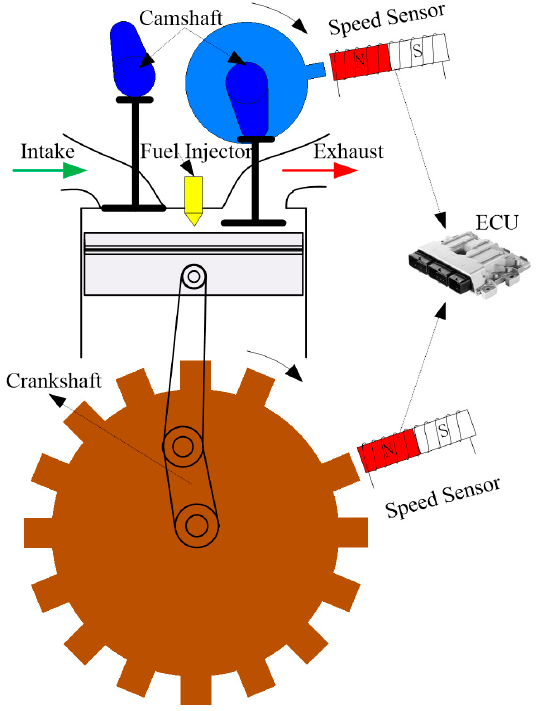
Figure 1. The schematic diagram for practical engine speed control system.